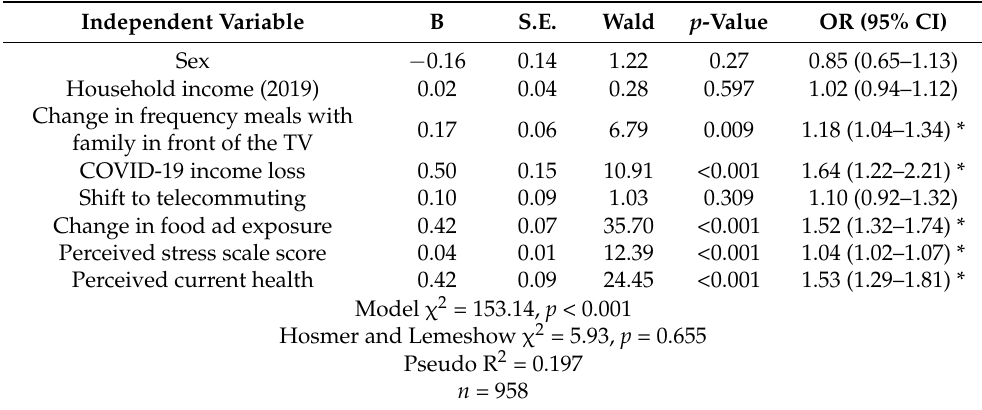
Table 3. Binary logistic regression analysis of perceived increase in dietary healthfulness ( n = 958). Independent